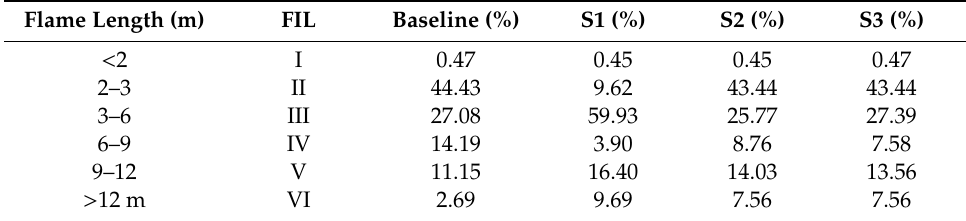
Table 4. Fire intensity level (FIL) area (%) estimated to the baseline period and the FMC scenarios. Flame Length (m)